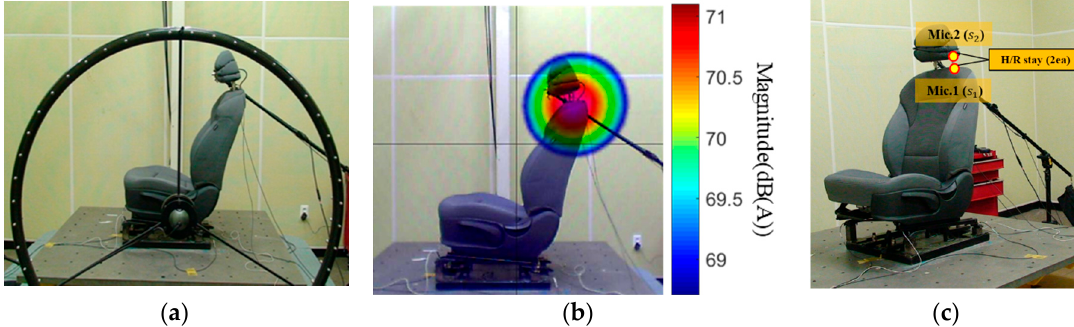
Figure 10. Experimental setup for the localization of rattle noise: ( a ) experimental setup, ( b ) result of the rattle noise localization, ( c ) microphone installation for ICA.